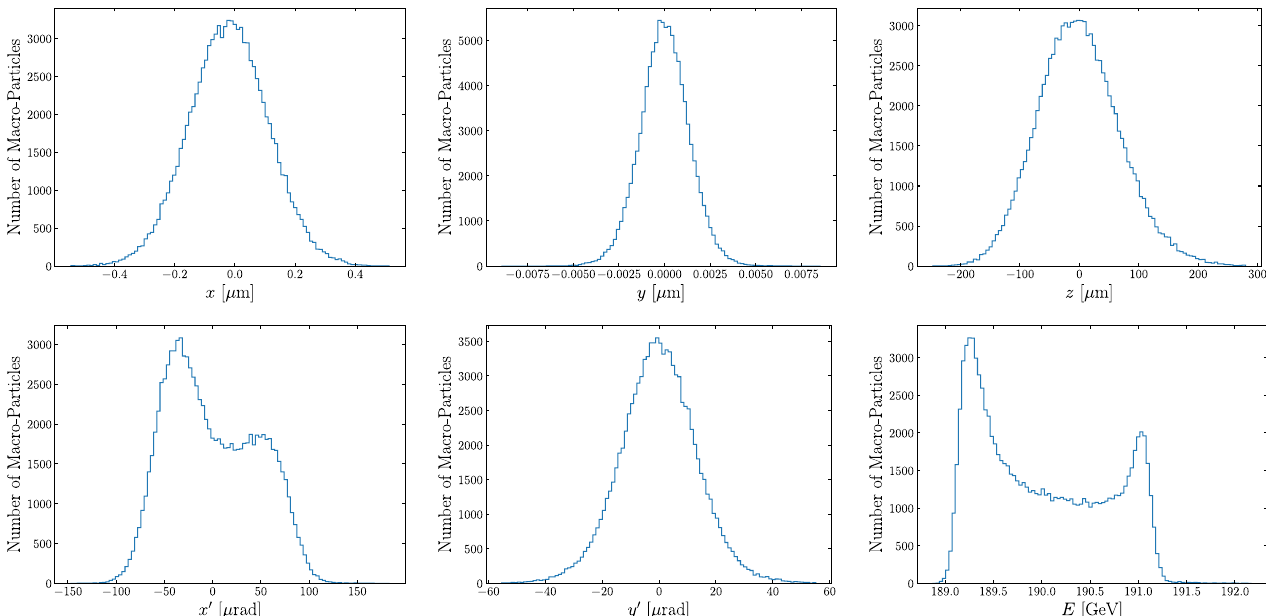
FIG. 3. Histogram of the horizontal position x (top left), vertical position y (top center), longitudinal position z (top right), horizontal angle x 0 (bottom left), vertical angle y 0 (bottom center), and energy E (bottom right) of a beam tracked through a perfect beamline.